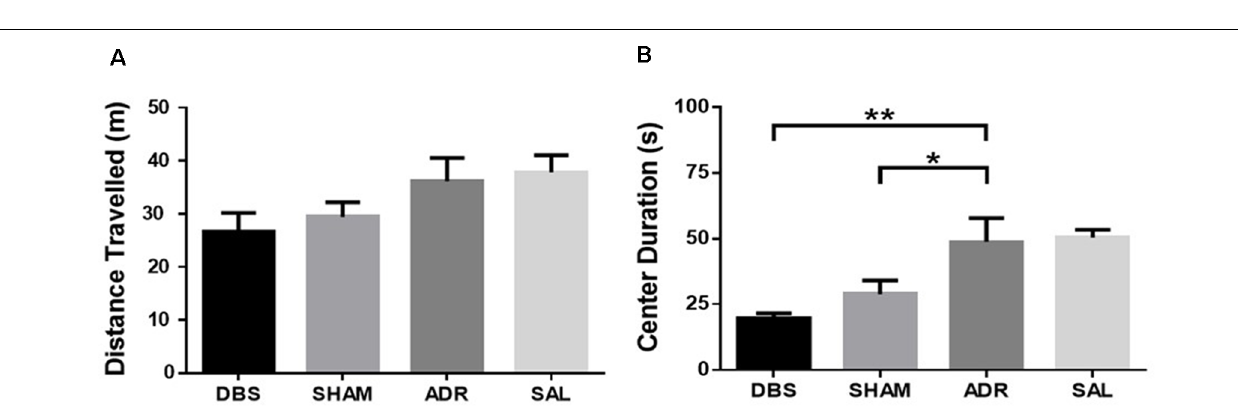
immobile for significantly less time relative to control ACTH- treated rats (ADR). No significant difference was observed in immobility time between the SHAM group and